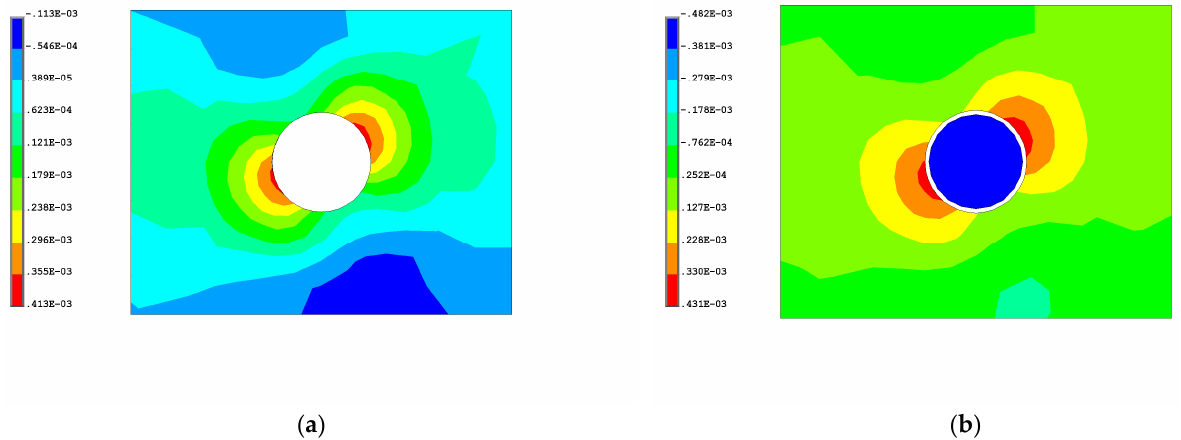
Figure 9. Strain in the transverse direction: ( a ) On the contact surface between beams; ( b ) Section view on the contact surface between beams.